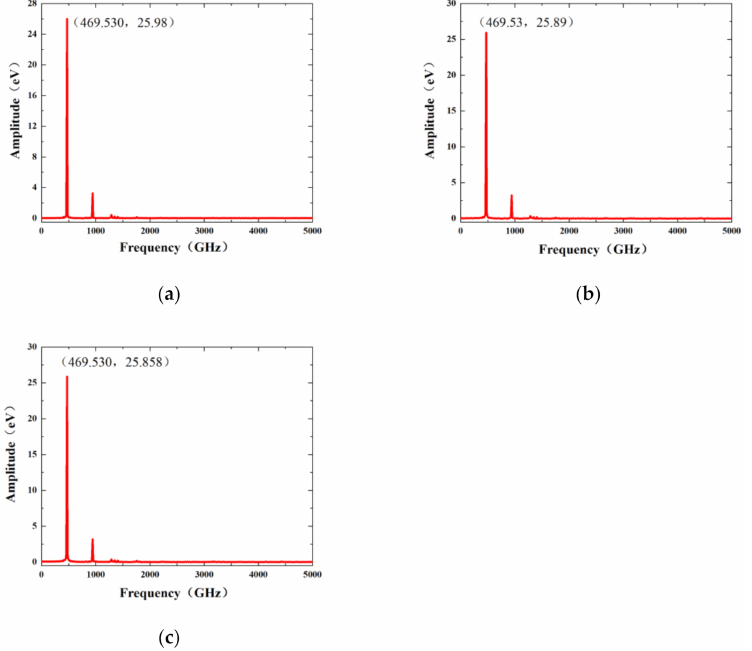
Figure 4. Frequency response curve of single-atom vacancy graphene under 10.175 nN external force: ( a ) SV-1 frequency response curve, ( b ) SV-2 frequency response curve, ( c ) SV-3 frequency response curve.